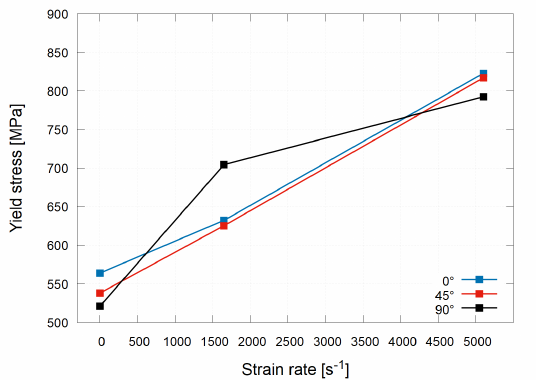
Figure 9. Dependency of the yield stress R p 1.0 on the strain